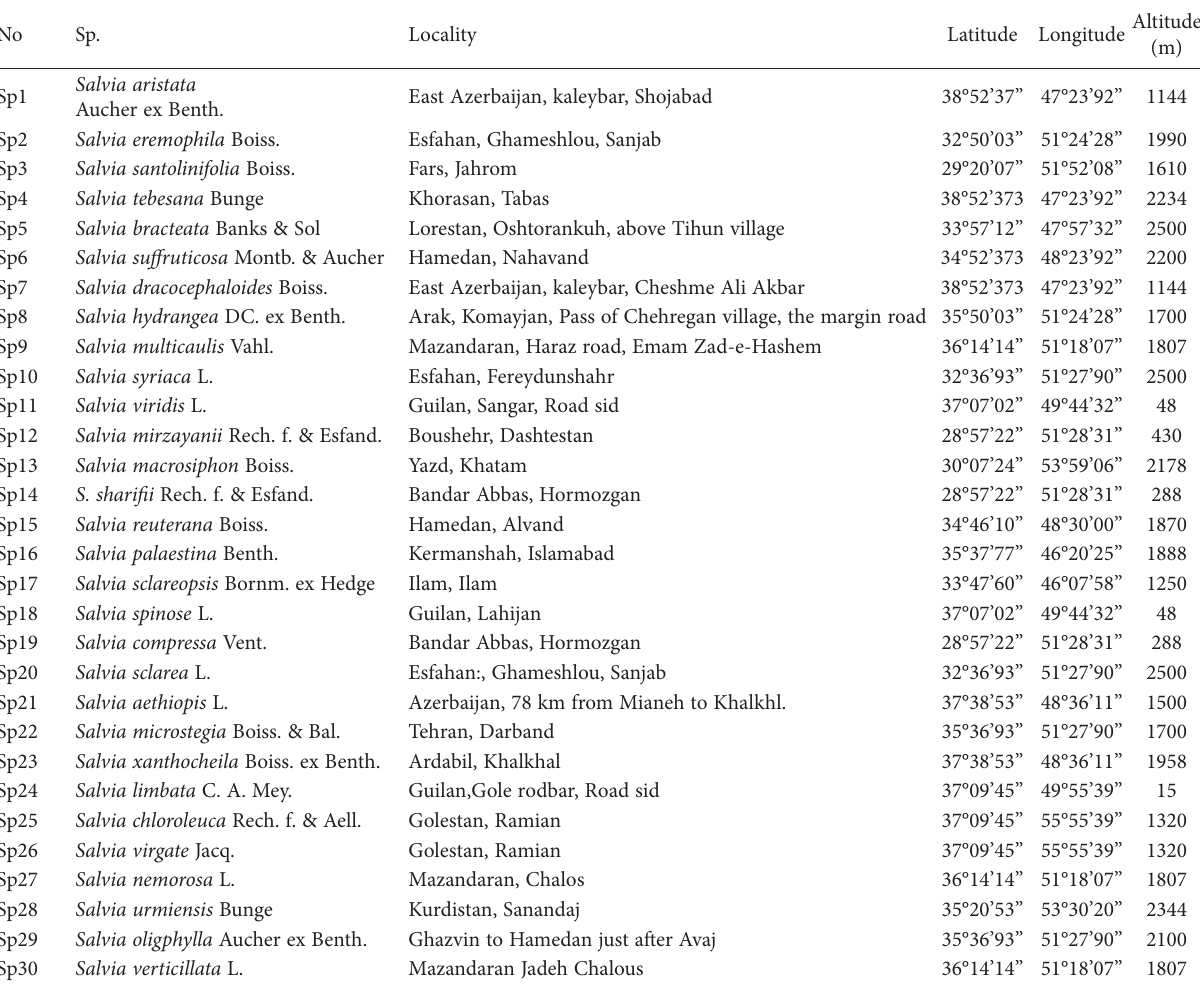
Table 1. Voucher details of Salvia species in this study from Iran by